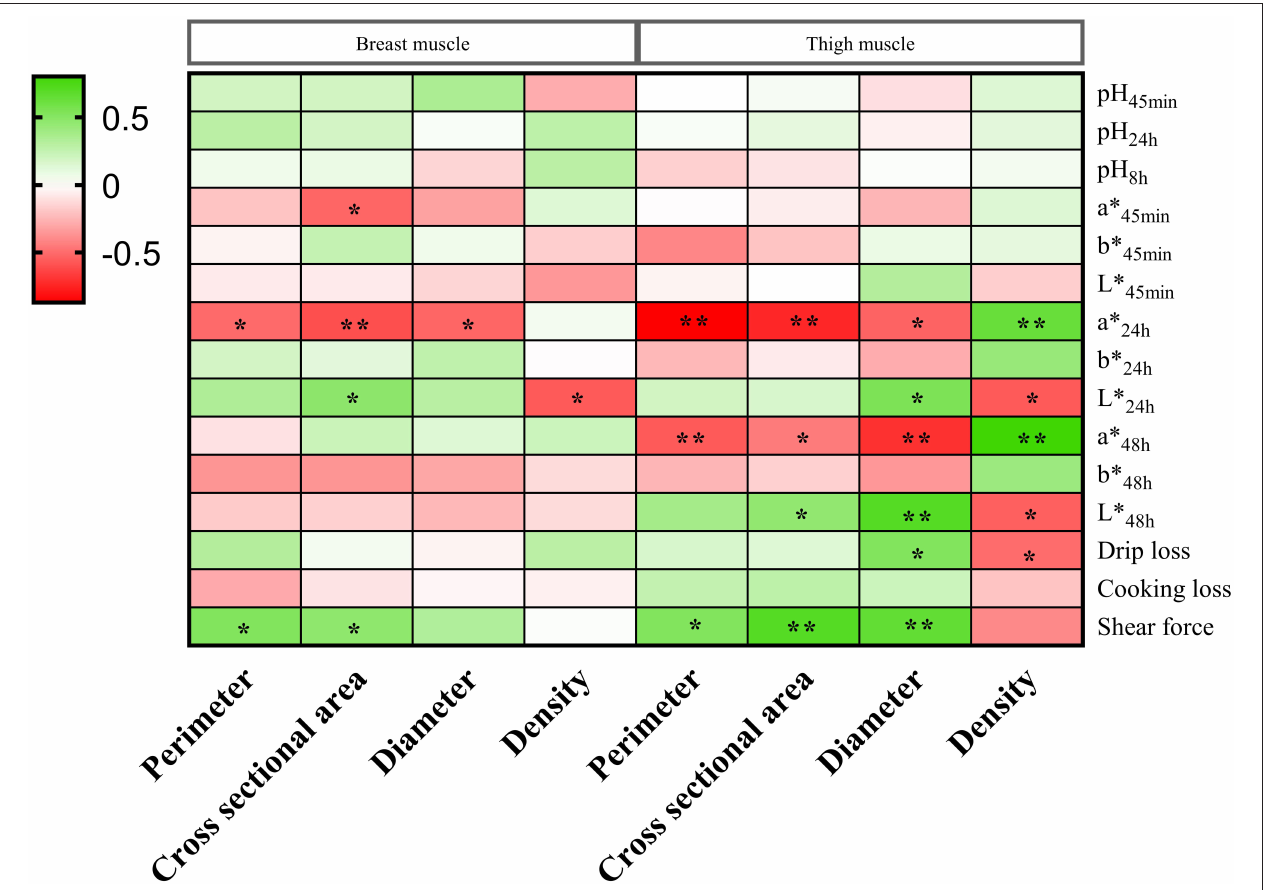
FIGURE 2 | The correlations between the meat quality and muscle fiber characteristics in the breast and thigh muscles of three-yellow chickens. * means significant difference ( p < 0.05); ** means highly significant difference ( p < 0.01).